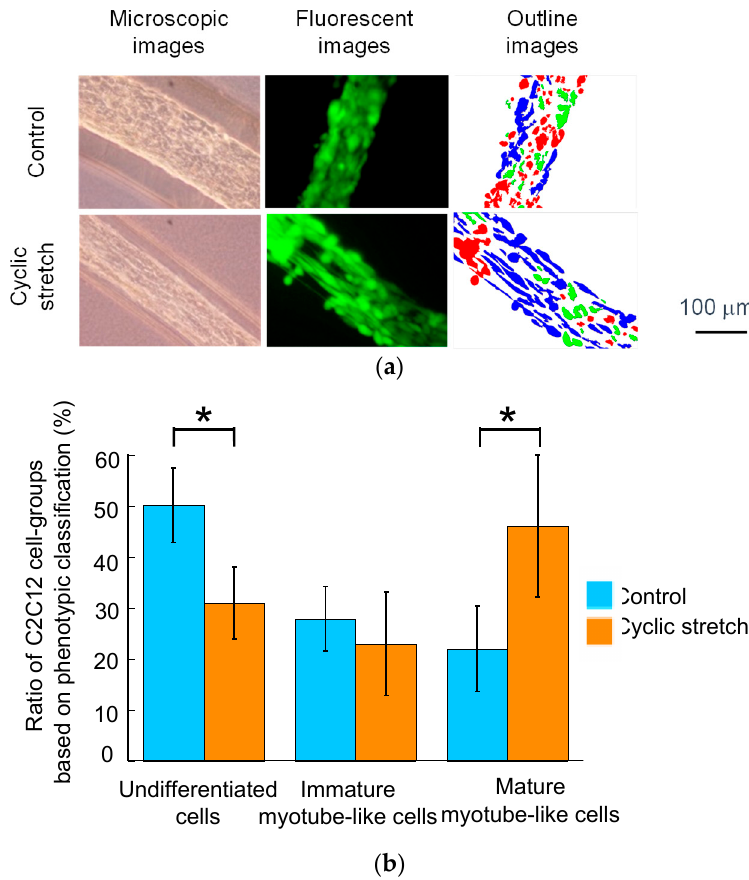
Figure 7. ( a ) Image-based classification of cells (blue: Mature, green: Immature, and red: Undifferentiated) and ( b ) the ratio of three types of C2C12 cells in the cell laden microfibers. A * indicate a significant difference ( p < 0.05) between control and cyclic stretch groups. Scale bar: 100 μ m.